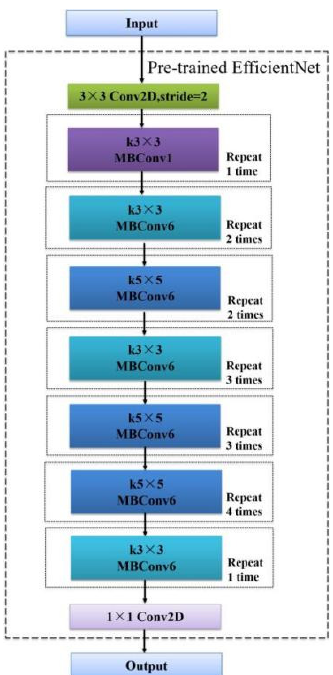
Figure 5. The Schematic representation of EfficientNet.